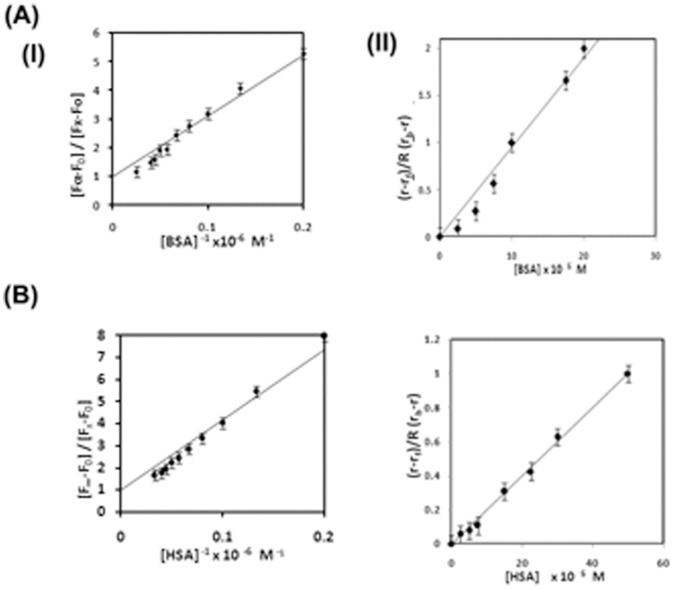
The plot of (A) (I) [F∞ − F0]/[Fx − F0] against [BSA]−1(II) (r−rf)/R(rb−r) against [BSA]; (B) (I) and (II) similar plot for HSA.